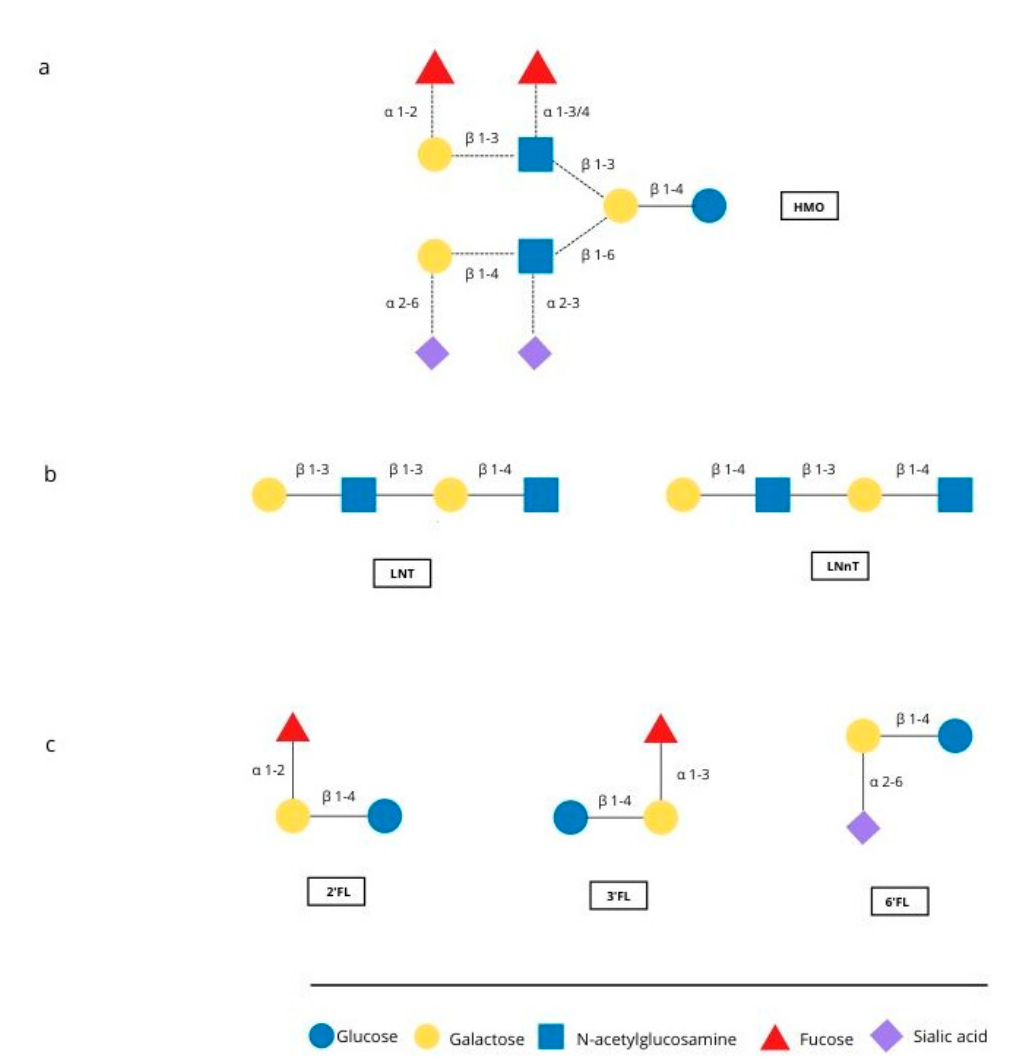
Figure 1. Representative structure of HMO and the major oligosaccharides found in breast milk. ( a ) Possible linkages of HMO building blocks, ( b ) type 1 (LNT) and type 2 chains (LNnT) ( c ) structures of 2 ′ FL, 3 ′ FL and 6 ′ FL.